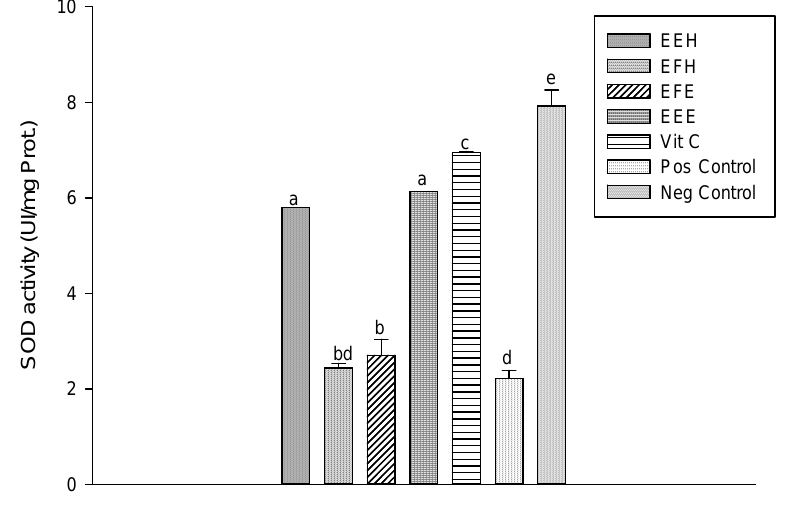
Figure 9. Protective properties of plant extracts: SOD activity. Values are expressed as mean ± SD of three replicates. In the same column the values labeled with different letters differ significantly at p < 0.05. EEE: H. zenkeri ( bark) ethanolic extract; EFE: H. zenkeri (leaves) ethanolic extract; EEH: H. zenkeri (bark) hydro-ethanolic extract; EFH: H. zenkeri (leaves) hydro-ethanolic extract; Vit C: Vitamin C. Pos Control: oxidant (positive) control. Neg Control: Normal (negative)